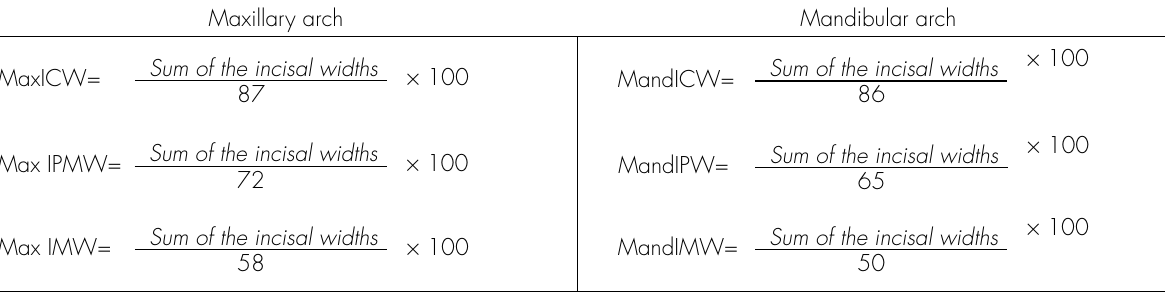
Table VIII. Prediction